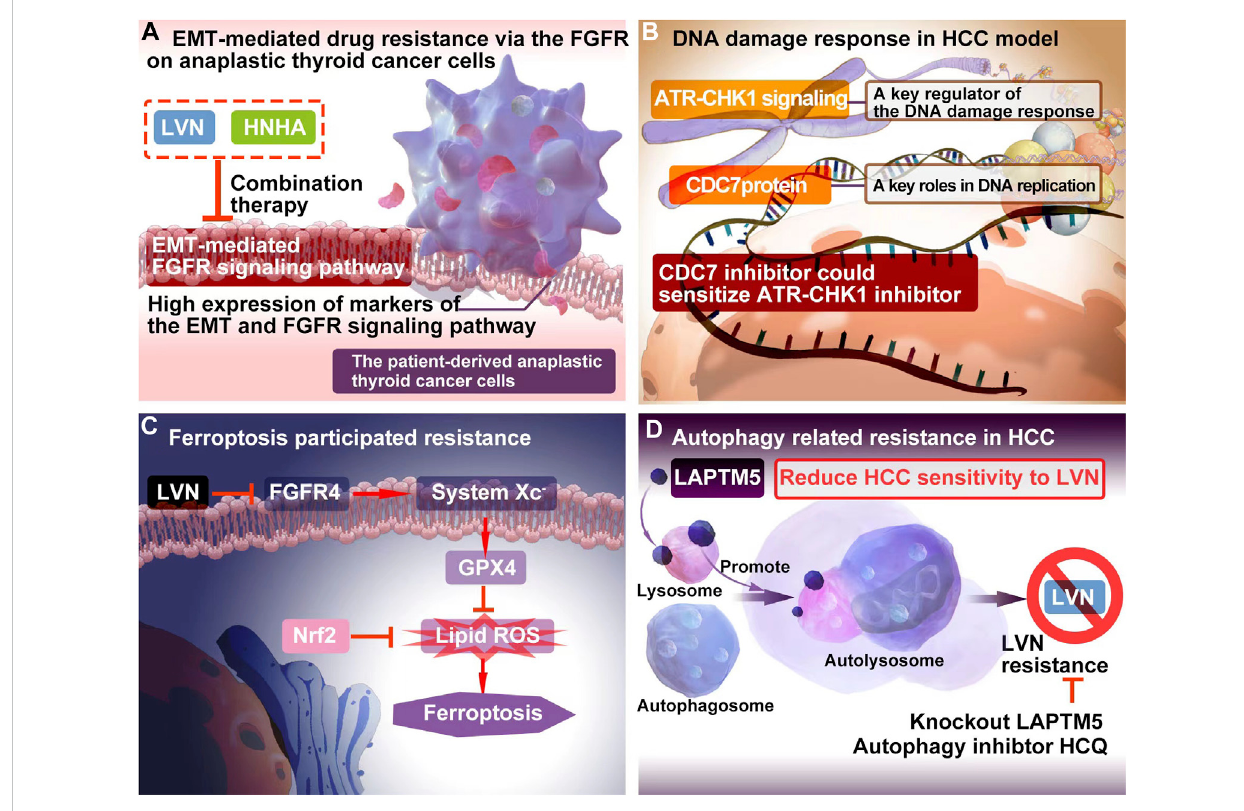
FIGURE 2 The resistance mechanism focuing on EMT, DNA damage, ferroptosis and autophagy of LVN. (A) EMT-mediated drug resistance via the FGFR onanaplastic thyroid cancer cells. (B) The combination of DNA damage response regulator with the inhibitor of CDC7 could bring out better therapuetic outcome of LVN inHCC via inhibiting DDRmediated drug resistance. (C) LVN involved in inhibition of ferroptosis participating process throughblockage of the cystine import activity of GPX4. (D) Blocking intrinsic autophagic fl ux by knockout LAPTM5 or adding autophagy inhibtor, HCQ, could be overcome resistance caused by